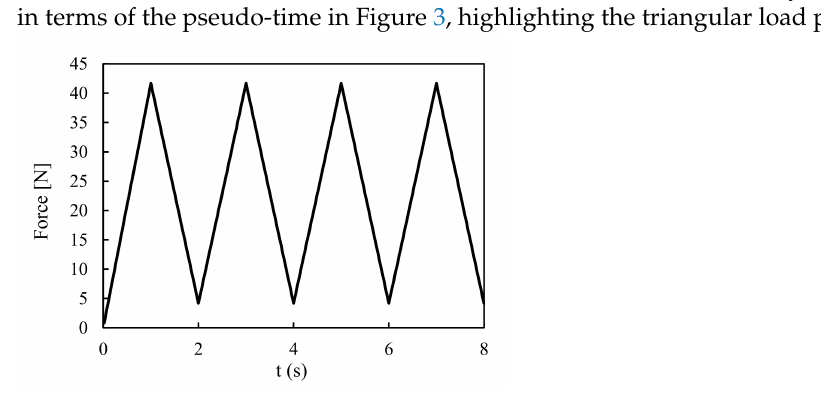
Figure 3. Loading cycles applied to the CT specimen. F min = 4.17 N, F max = 41.67 N, R = 0.1. During loading, the crack path arises in the symmetry plane of the CT